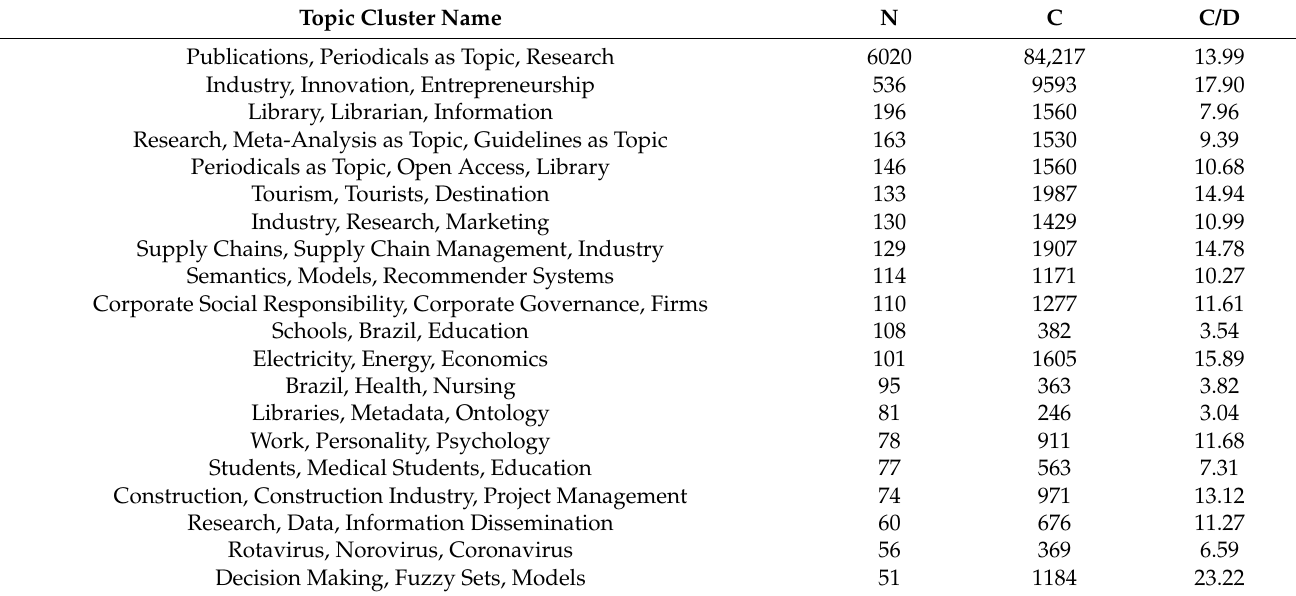
Table 3. Topic Cluster Name (Scival) for bibliometrics